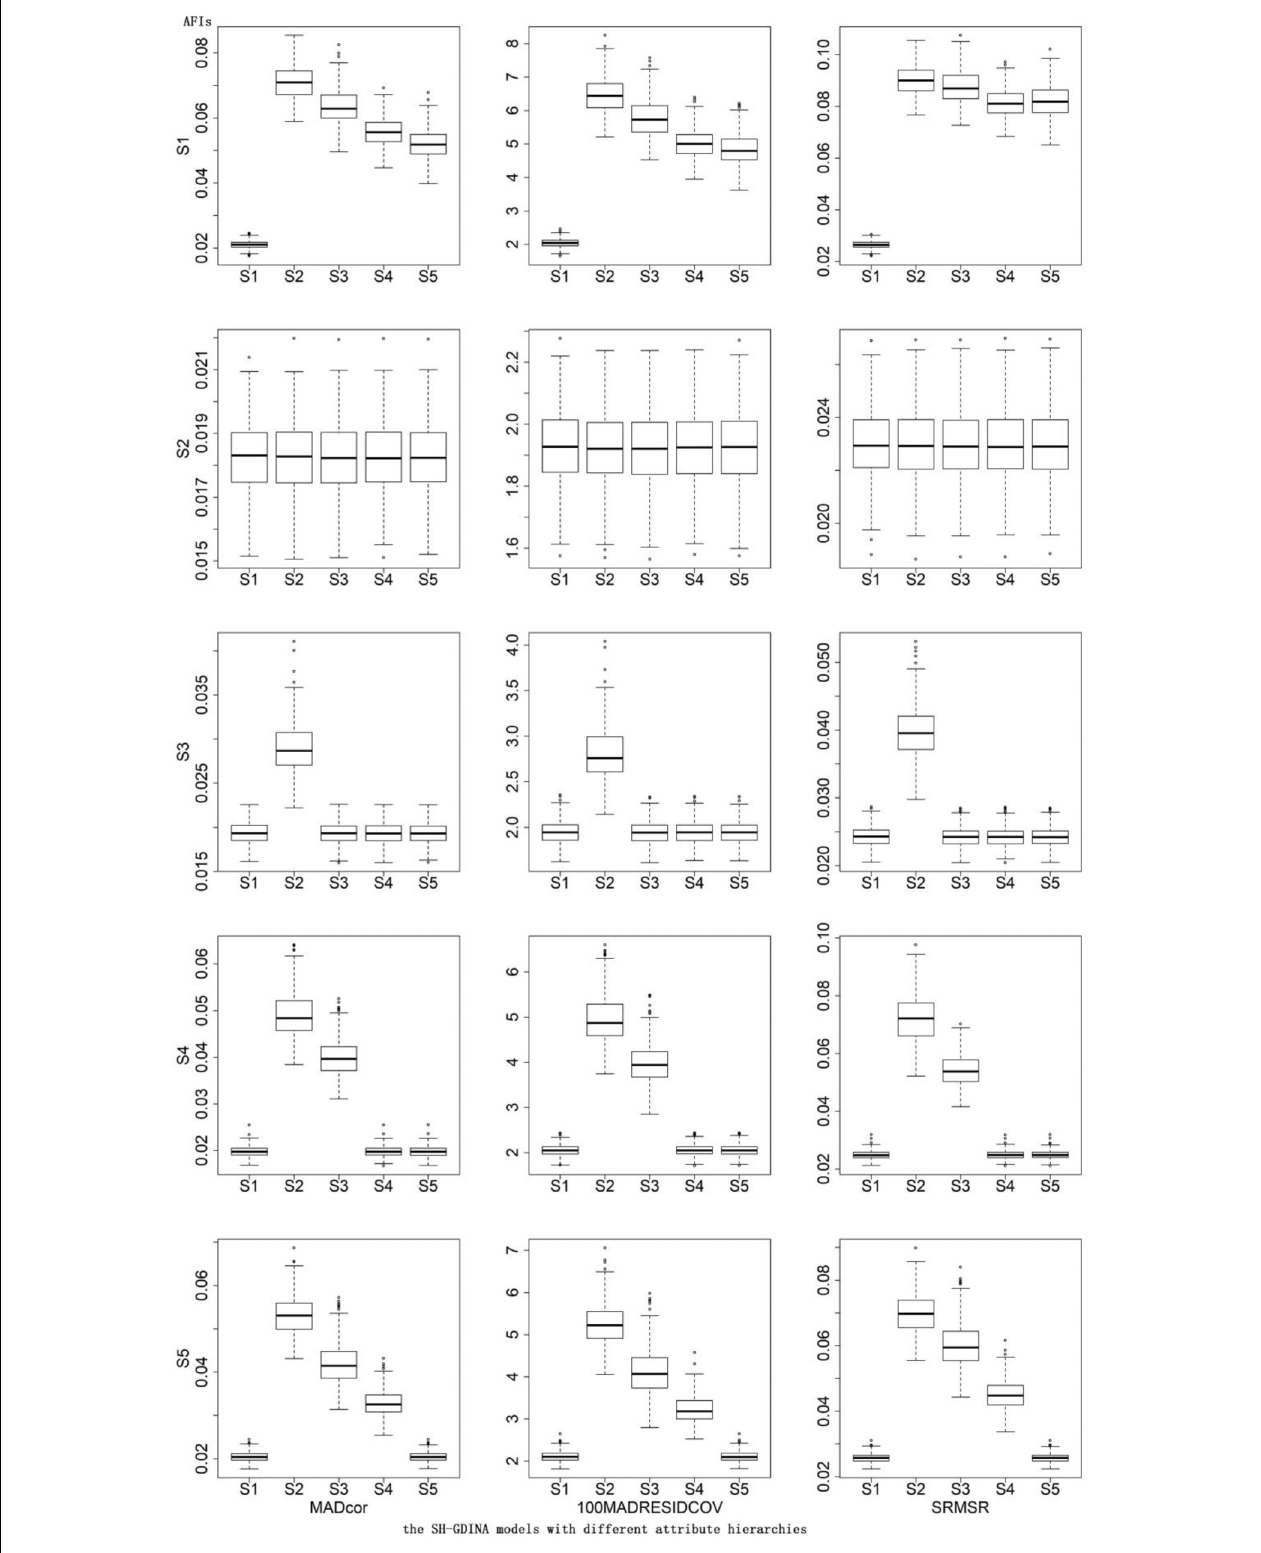
FIGURE 3 | Box plots of absolute fit indices (AFIs) in high item quality cases of simulation study II.